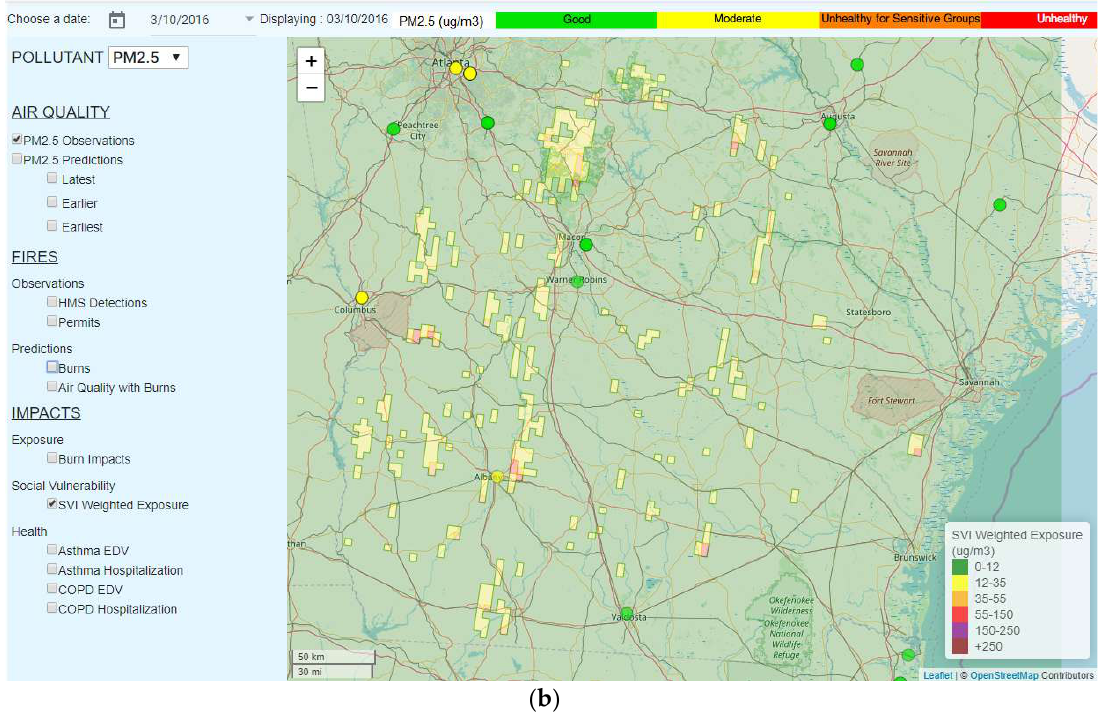
Figure A6. (a) Spatial distribution of the SVI index over southeastern U.S., and (b) the SVI‐weighted Figure A6. ( a ) Spatial distribution of the SVI index over southeastern U.S., and ( b ) the SVI-weighted exposures to smoke causing increases in PM 2.5 levels on 10 March 2016. exposures to smoke causing increases in PM 2.5 levels on 10 March 2016.